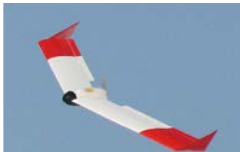
Figure 1: PAMS UAV (Germatics GmbH,